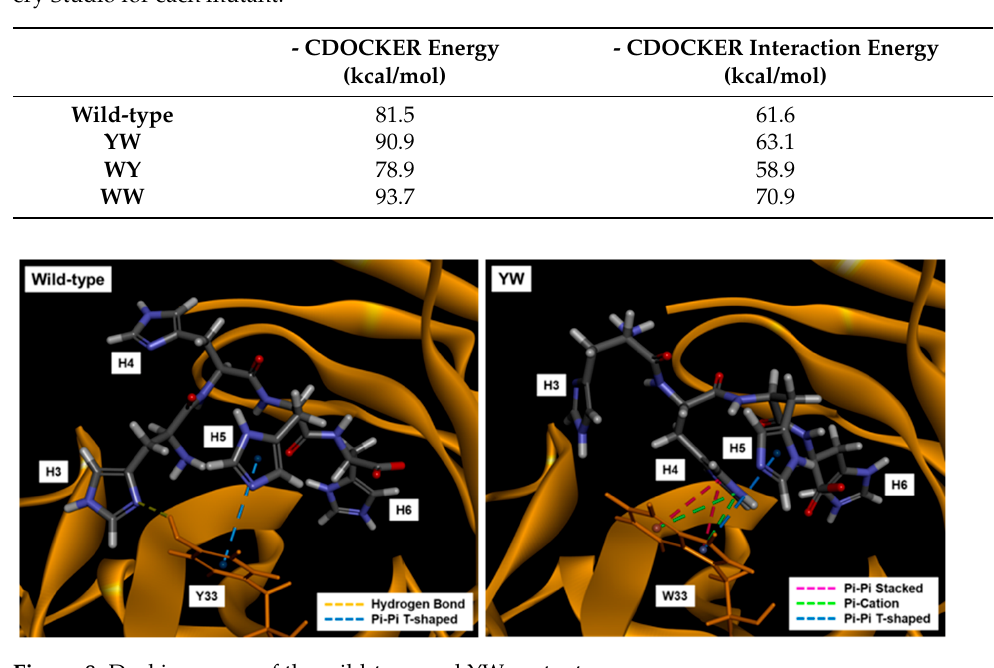
Table 4. -CDOCKER Energy and -CDOCKER Interaction Energy calculated by CDOCKER in Dis- covery Studio for each mutant.